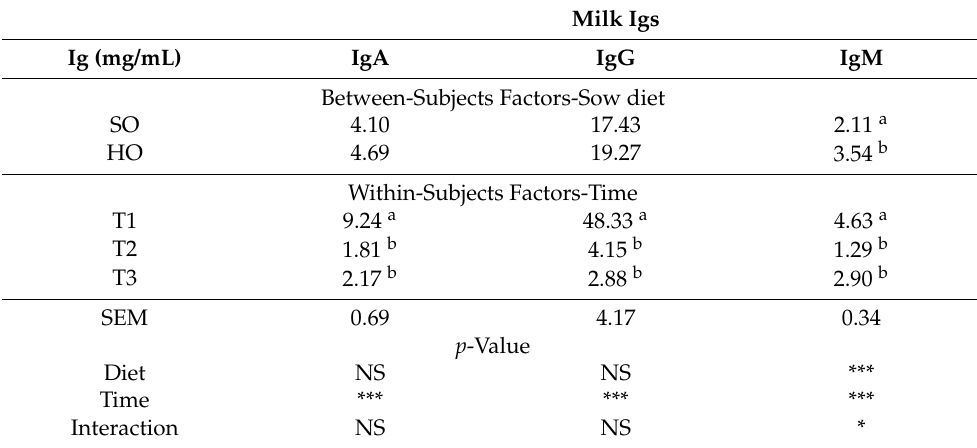
Table 5. Ig composition of milk from sows fed a classical diet based on soybean oil (SO) or a rich n-3 FA and lower n-6:n-3 ratio diet based on hemp seed oil (HO) at different time points after farrowing (12 h, 10 days, and 21 days).